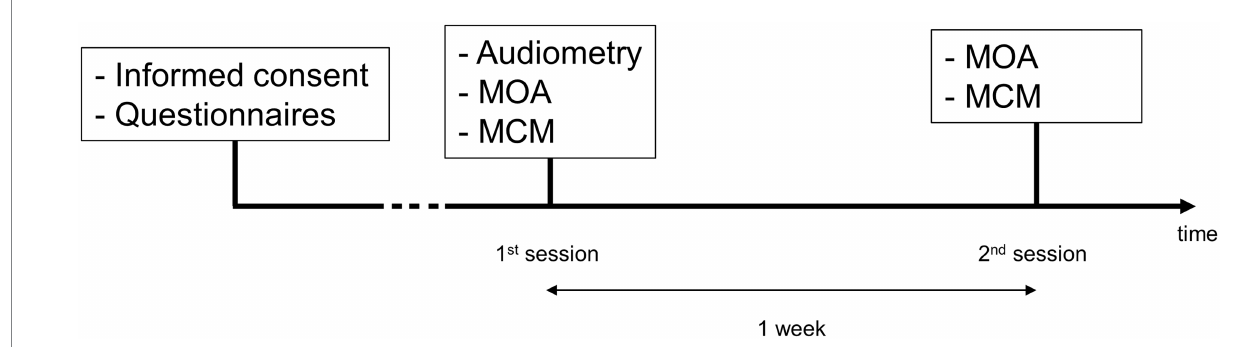
FIGURE 3 Timeline of the experiment. The measurements are shown in chronological order for each session.